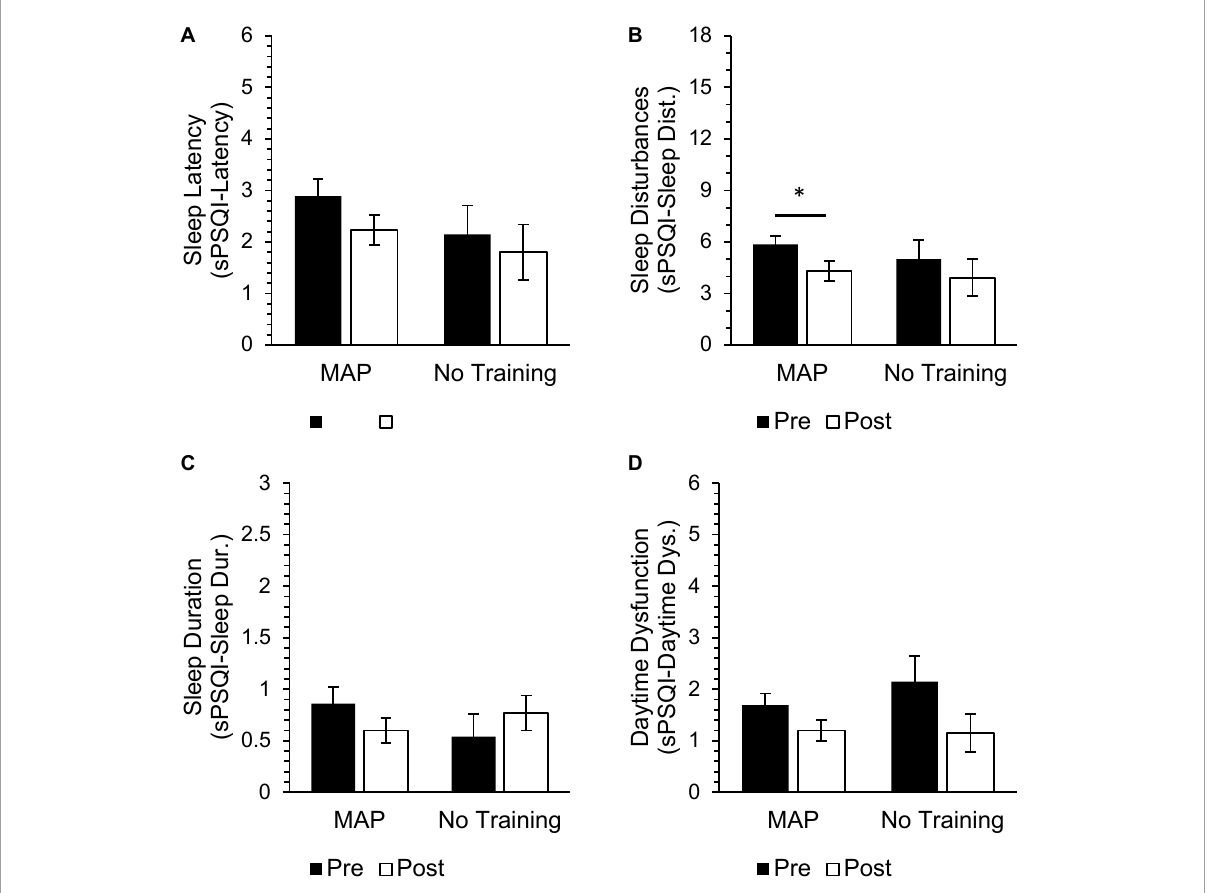
FIGURE7 MAP participants reported a significant reduction in sleep disturbances post-intervention [ (B) sPSQI-Sleep Disturbances]. MAP participants did not report any significant changes in other aspects of sleep quality, including sleep latency [ (A) sPSQI-Latency], sleep duration [ (C) sPSQI-Sleep Duration], and daytime dysfunction [ (D) sPSQI-Daytime Dysfunction]. There were no significant differences between pre-intervention and post-intervention scores on health measures in the No Training group. There were also no significant differences between groups on these measures at either timepoint. Asterisks indicate significant adjusted p